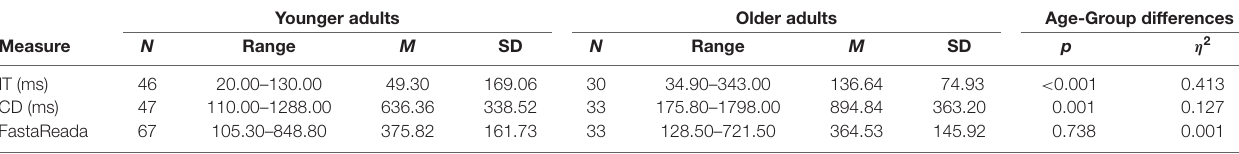
TABLE 3 | Descriptive statistics and independent samples T -test for mean difference for scores on the IT, CD, and FastaReada in younger and older adults. Younger adults